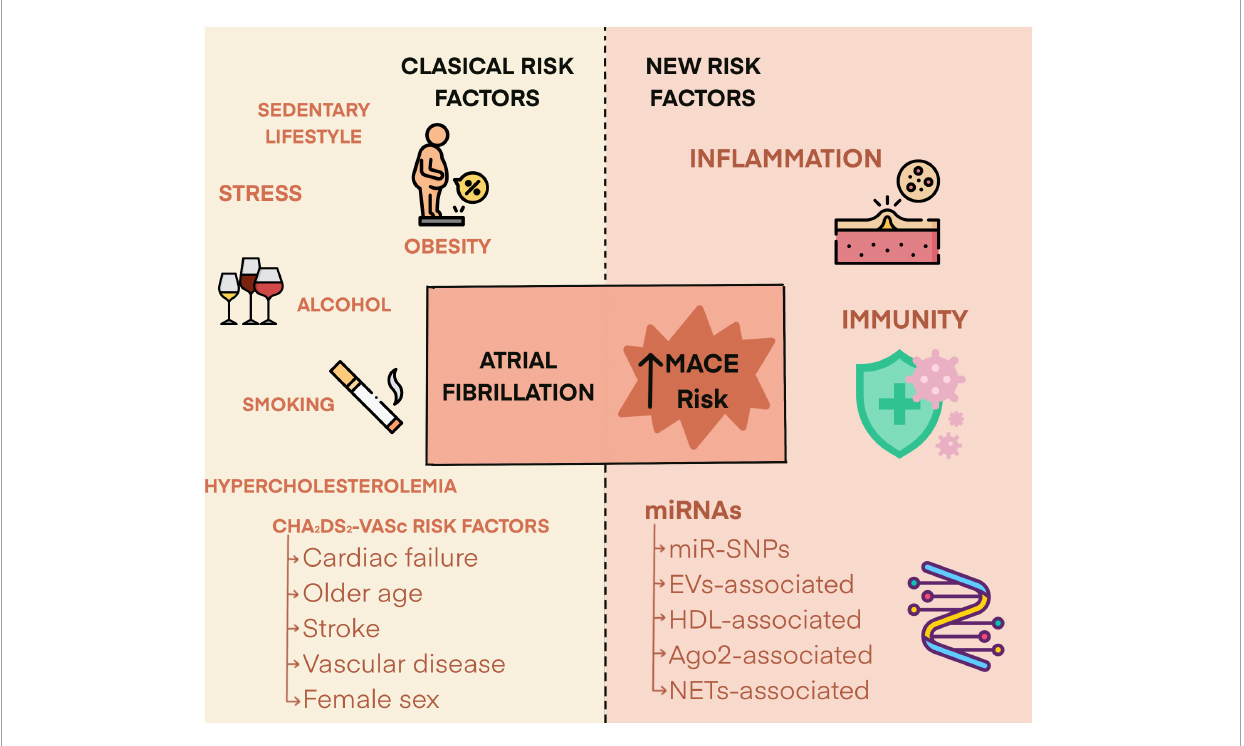
FIGURE1 Risk factors determining the risk of major adverse cardiovascular events in atrial fibrillation patients.